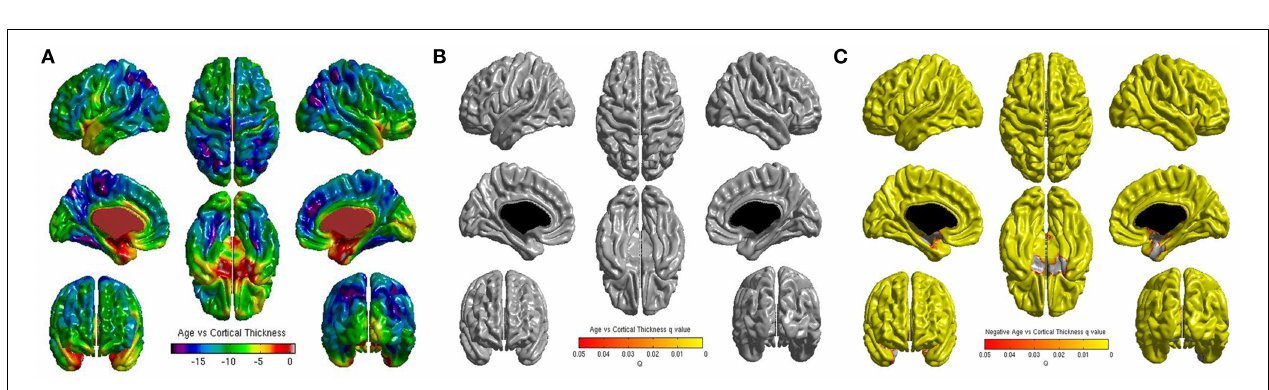
age and cortical thickness across the entire brain corrected for multiple comparisons with FDR q = 0 . 05 (C) Negative correlations between BMI Z-Score for age and cortical corrected for multiple comparisons with FDR q = 0 . 05 .